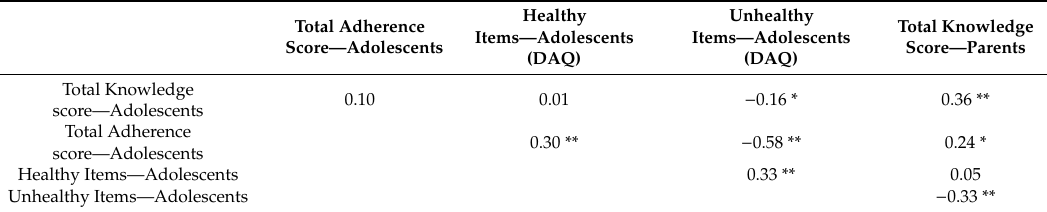
Table 6. Correlations between the knowledge and adherence scores among